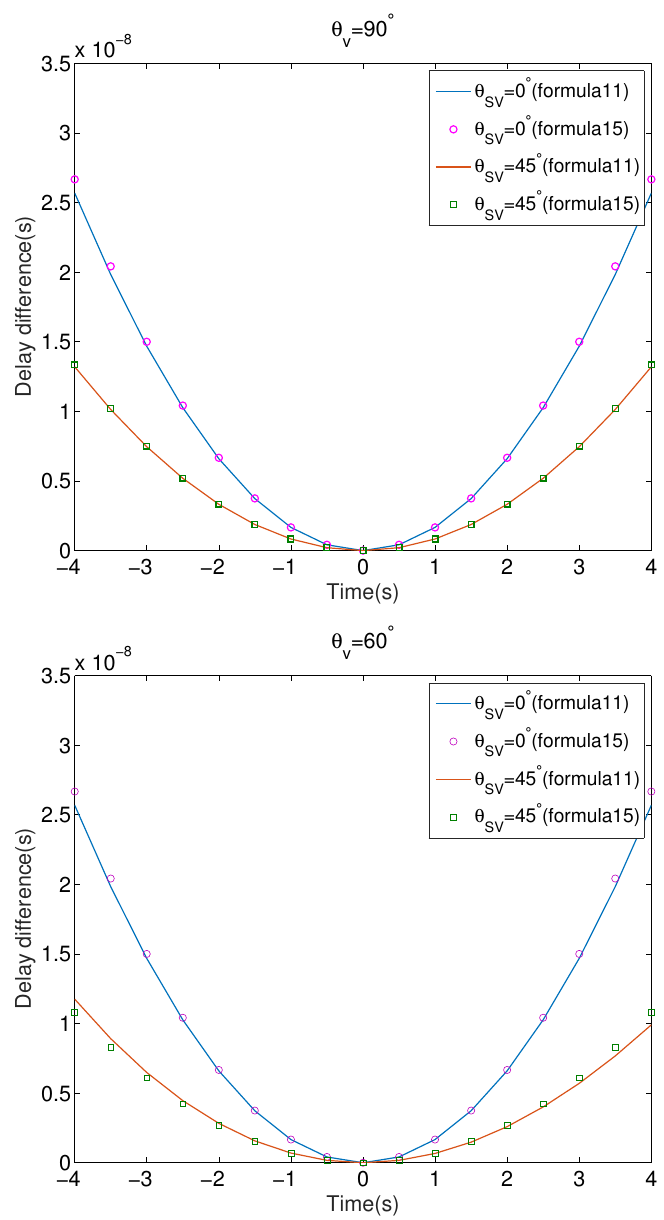
Figure 8. Different delay when the target crosses the